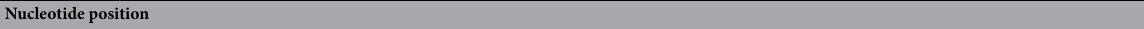
Table 3. List of mutations in SARS-CoV-2 strains detected in Malaysia in October